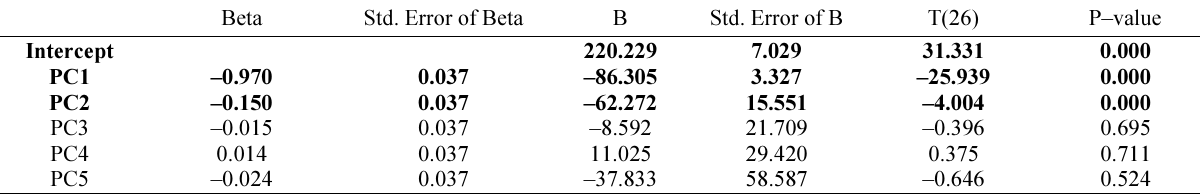
Table 6. Regression summary for operating cost ($/h) for backhoe